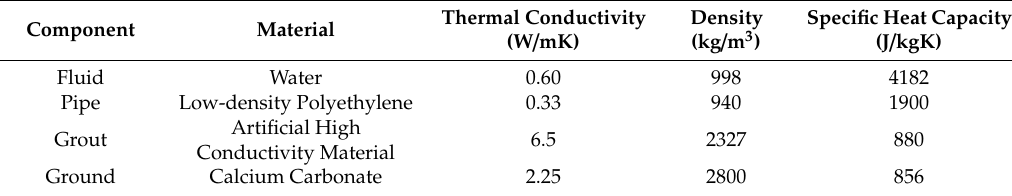
Table 1. Material properties of the components forming the ground heat